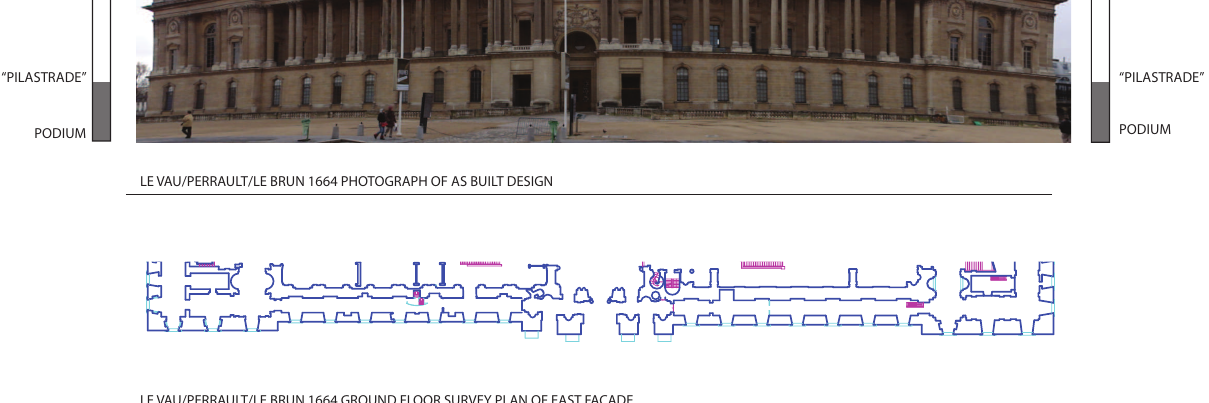
Figure 5: Diagram of Splits for the Le Vau/Perrault/Le Brun Design of